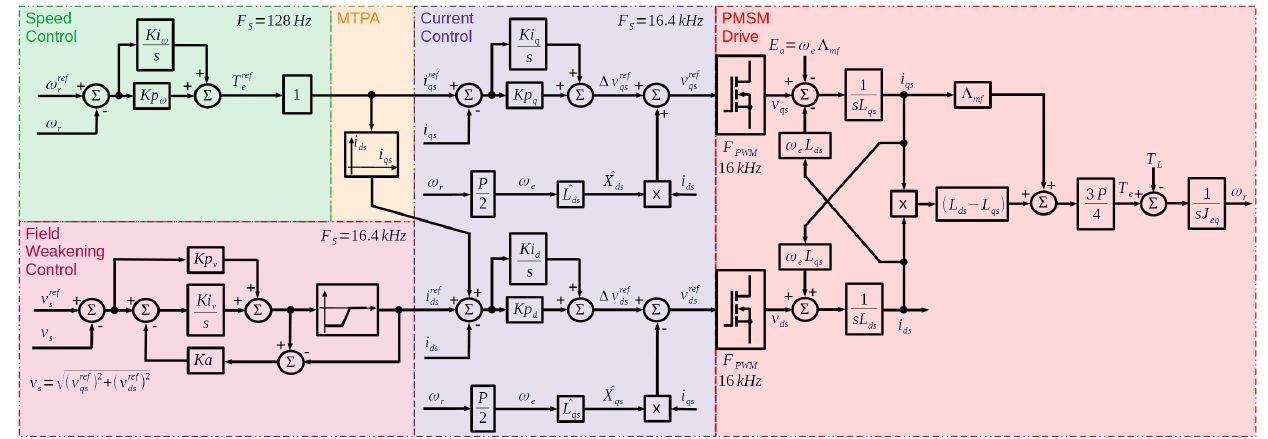
Figure 20. PMSM Drive